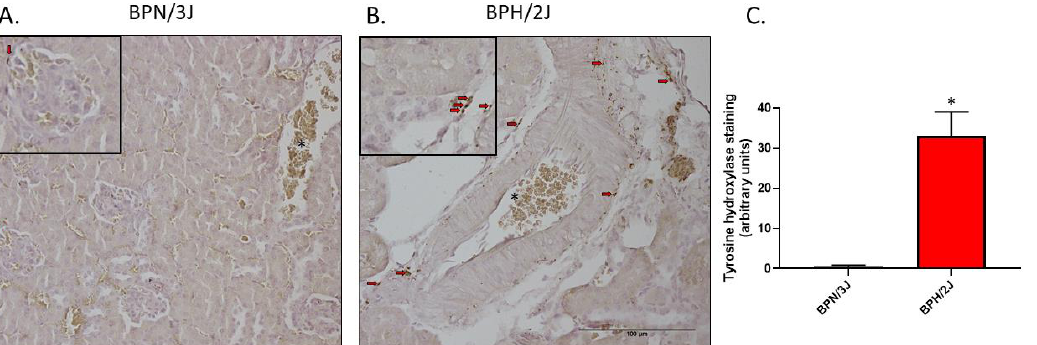
Figure 1. Tyrosine Hydroxylase is significantly increased in the kidneys of BPH/2J neurogenically hypertensive mice compared to BPN/3J normotensive mice. Representative Tyrosine Hydroxylase immunohistochemistry images of renal tissue of ( A ) normotensive mice or ( B ) neurogenically hy- pertensive mice, * in ( A ) and ( B ) indicates erythrocytes. ( C ) Quantitation of TH staining in kidneys. * p = 0.0017; data represented as mean ± SEM; n = 4/group. Red arrows = TH staining; Bar = 100 μ m (as indicated by image ( B )).